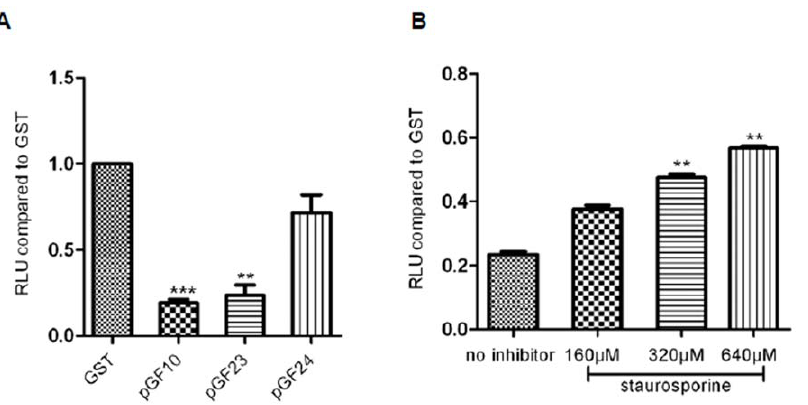
Figure 4. The kinase activities of GST fusion proteins were measured invitro . A. Phosphorylation activities of GST fusion proteins containing full-length Stk (using plasmid pQG77), Stk 1–263 (pQG78) or Stk 40–263 (pQG79) were measured with a Kinase-Glo TM luminescent kinase assay in vitro at 32 u C for 4 h. B. Phosphorylation activities of GST fusion proteins containing full-length Stk (using plasmid pQG77) were measured with a Kinase-Glo TM luminescent kinase assay with or without staurosporine in vitro at 32 u C for 4 h. GST was used as a negative control. RLU, relative luminescent unit. Data are derived from three independent experiments, **, P , 0.01; ***, P , 0.001 (versus GST).